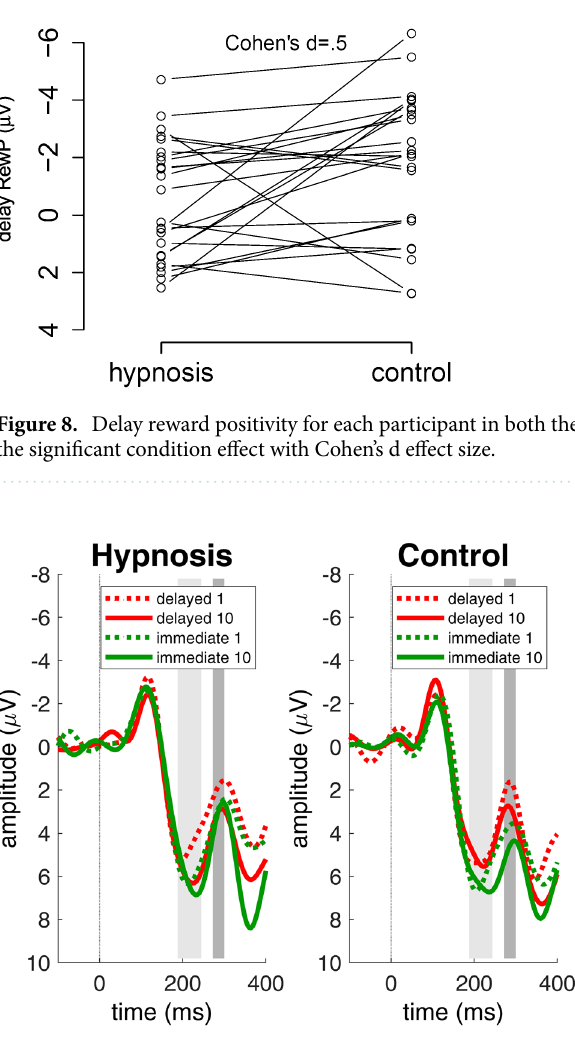
Figure 9. ERP responses to all four possible outcomes at FCz. For the delay reward positivity, the delayed outcomes (solid red and dotted red lines) and the immediate outcomes (solid green and dotted green lines) were aggregated over reward magnitude (1 or 10 cents). The lighter grey area indicates the P2 time window, the darker grey area indicates the delay reward positivity time window. Negative is plotted up by